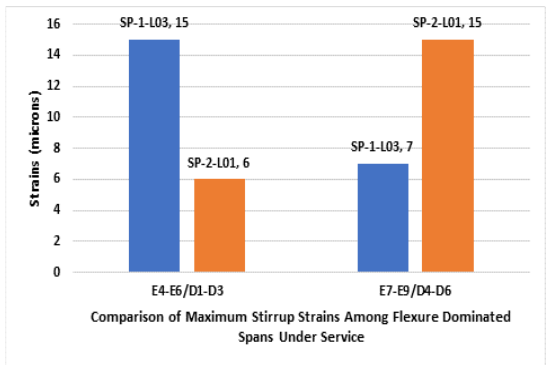
Figure 34. Comparison of maximum stirrup strains recorded for loading setup SP-1-L03 and SP-2-L01 under four-point service loads.